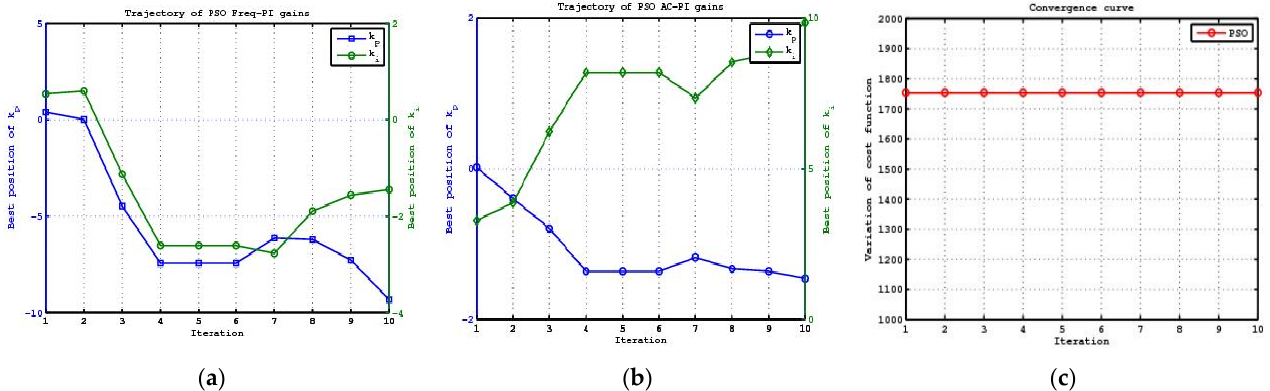
Figure 4. ( a ) Trajectory of frequency PI gain; ( b ) Trajectory of AC PI gain; ( c ) Convergence curve using Antlion algo- rithm(ALO).